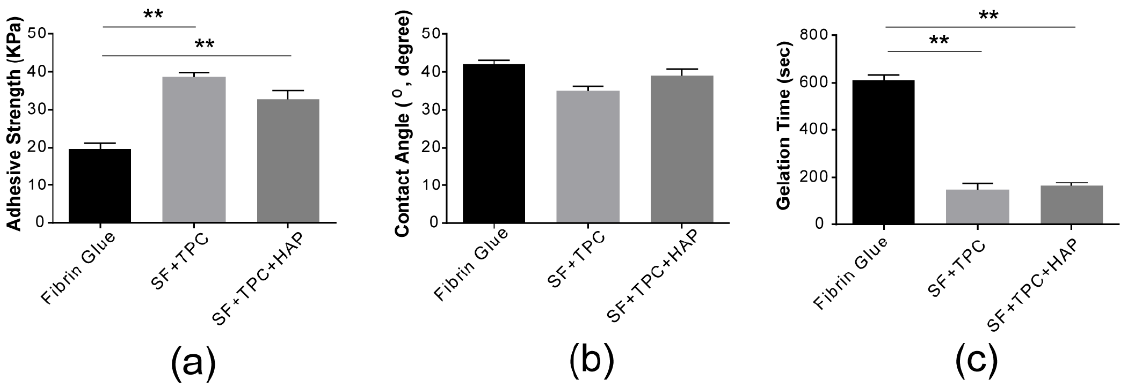
Figure 3. Structural analysis. ( a ) The adhesive strength of conventional fibrin glue was compared to silk fibroin protein in skin (SF + TPC) and in bone (SF + TPC + HAP). Silk fibroin showed about two times higher adhesive strength than conventional fibrin glue. ( b ) The contact angle of conventional fibrin glue was compared to silk fibroin protein in skin (SF + TPC) and in bone (SF + TPC + HAP). Overall, SF showed a lower contact angle compared to fibrin, suggesting greater hydrophilicity. ( c ) The gelation time. SF, silk fibroin; TPC, tannic acid and polyethylene glycol 2000 as curing agents; HAP, hydroxyapatite. n = 5. ** p < 0.001.